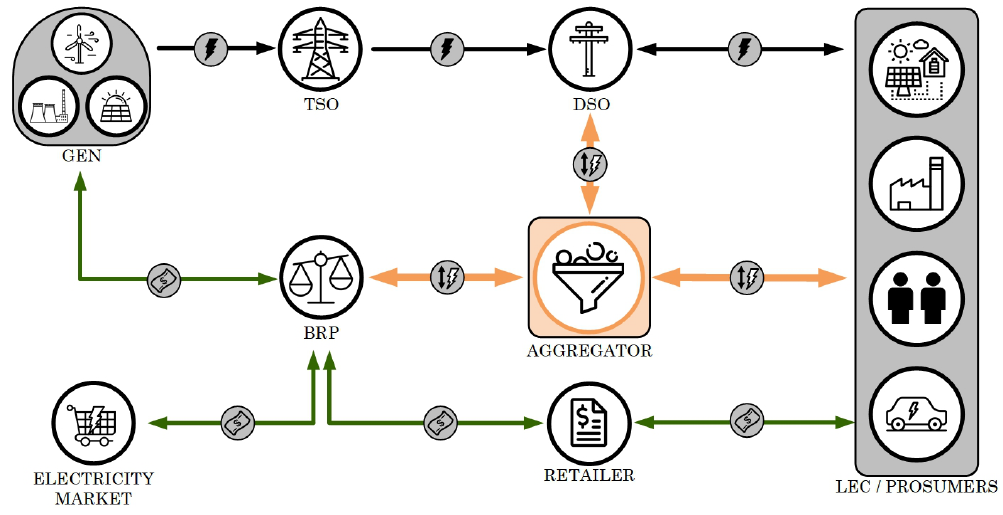
Figure 1. Local flexibility market overview. LEC, Local Energy